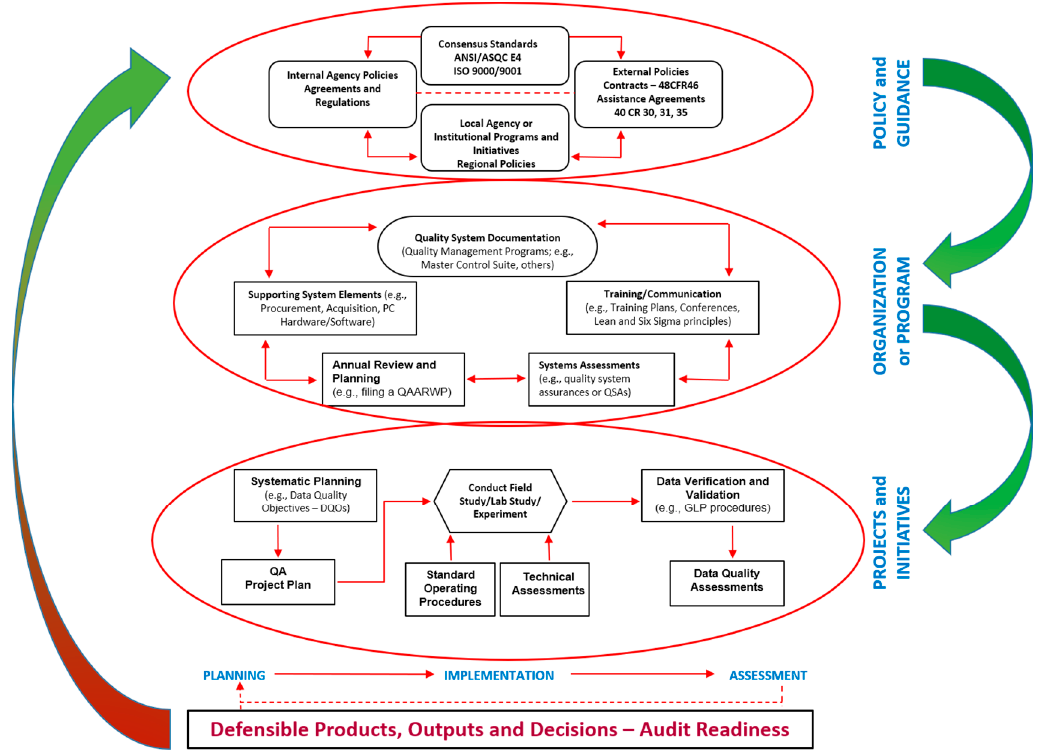
Figure 3. An example of a typical Quality System Components and Tools. The QMS is typically organised across three inter-dependent domains—Policies and Guidance; Organisation of the Program, and Projects, Programs and Initiatives. Adapted and Modified from the U.S. EPA’s technical guidance on Quality Systems and Quality Management [52]